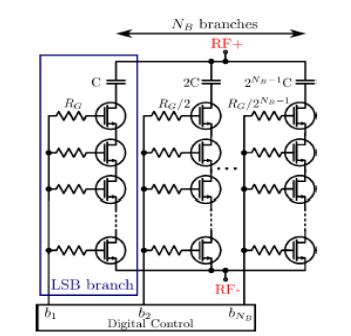
Figure. 1. Simplified schematic of the stacked-FET Tunable Capacitor